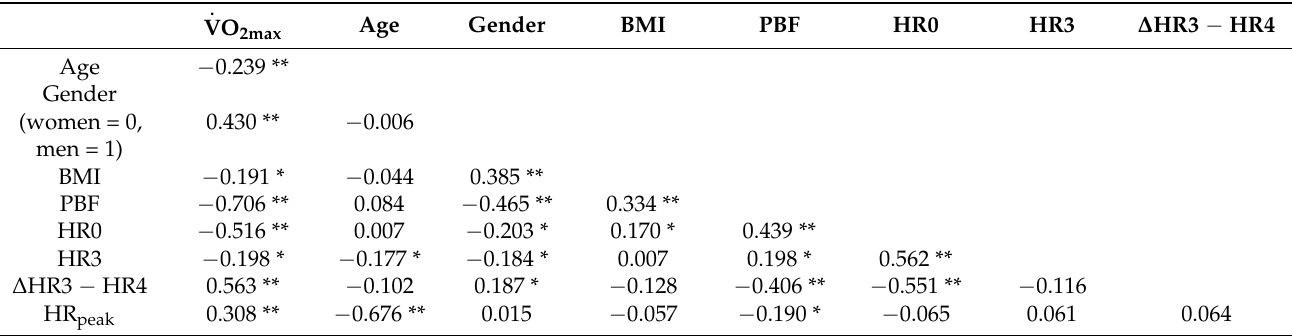
. Table 2 presents the Pearson’s correlations between measured VO 2max and indepen- dent variables in the training group. The results showed that age (r = − 0.239, p = 0.004), BMI (r = − 0.191, p = 0.022), PBF (r = − 0.706, p < 0.001), and HR0 (r = − 0.516, p < 0.001) . all had significant negative correlations with VO 2max , while gender (women = 0, men = 1) . and ∆ HR3 − HR4 both had positive correlations with VO 2max (gender: r = 0.430, p < 0.001; ∆ HR3 − HR4: r = 0.563, p < 0.001). . Table 2. Pearson correlation coefficients for the correlations between VO 2max and independent variables in the training group. . VO 2max Age Gender